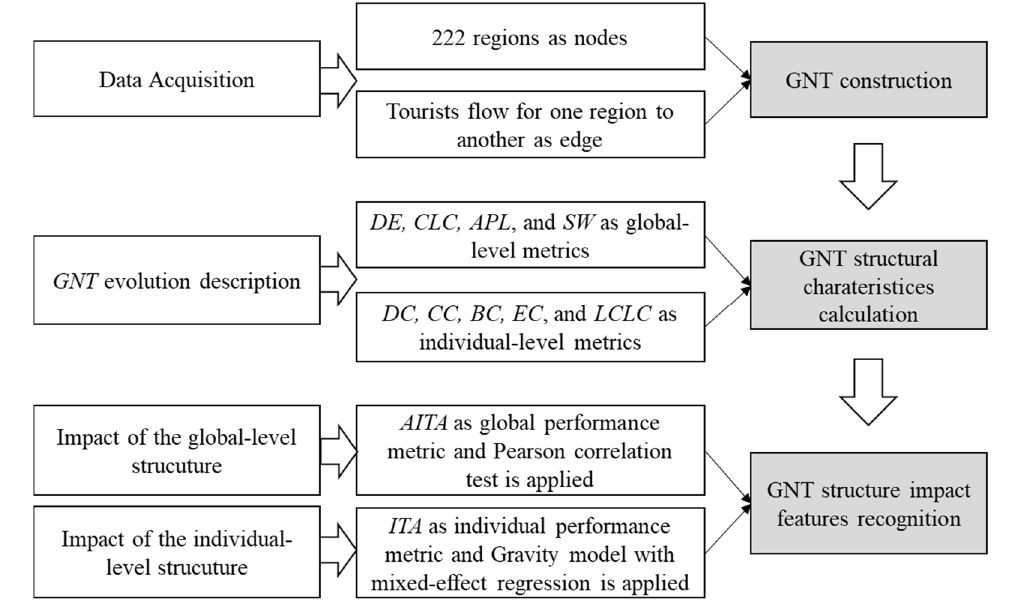
Figure 1. The framework of research.